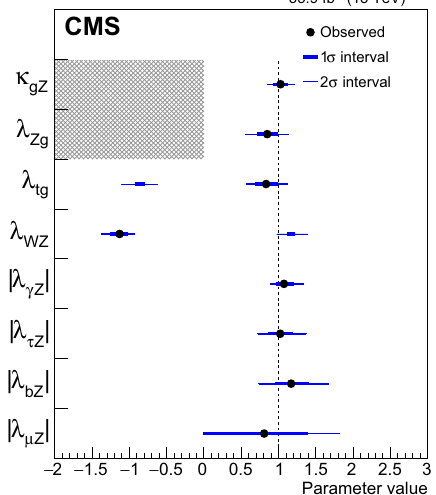
Fig. 16 Summary of the model with coupling ratios and effective cou- plings for the ggH and H → γγ loops. The points indicate the best fit values while the thick and thin horizontal bars show the 1 σ and 2 σ CL intervals, respectively. For this model, both positive and negative values of λ WZ and λ tg are considered